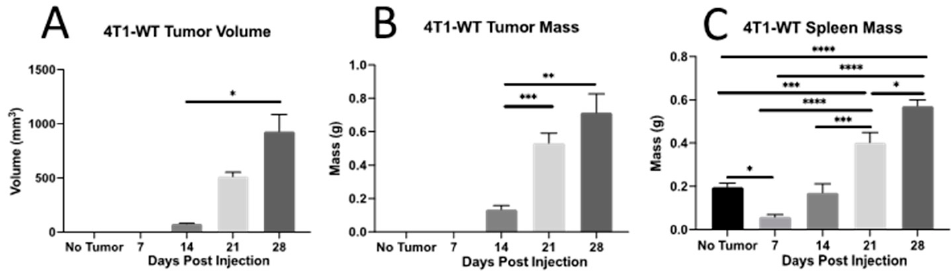
Figure 1. Tumor and spleen sizes in 4T1 tumor-bearing animals. The 4T1-WT mammary carcinoma cells (10 4 ) were engrafted into the mammary gland of BALB/cJ mice, and animals were assessed for ( A ) tumor volume, ( B ) tumor mass, and ( C ) spleen mass at the times indicated. Data are represented as mean ± SEM; n = 4–11 mice per time point. * p < 0.05, ** p < 0.01, *** p < 0.001, and **** p < 0.0001.